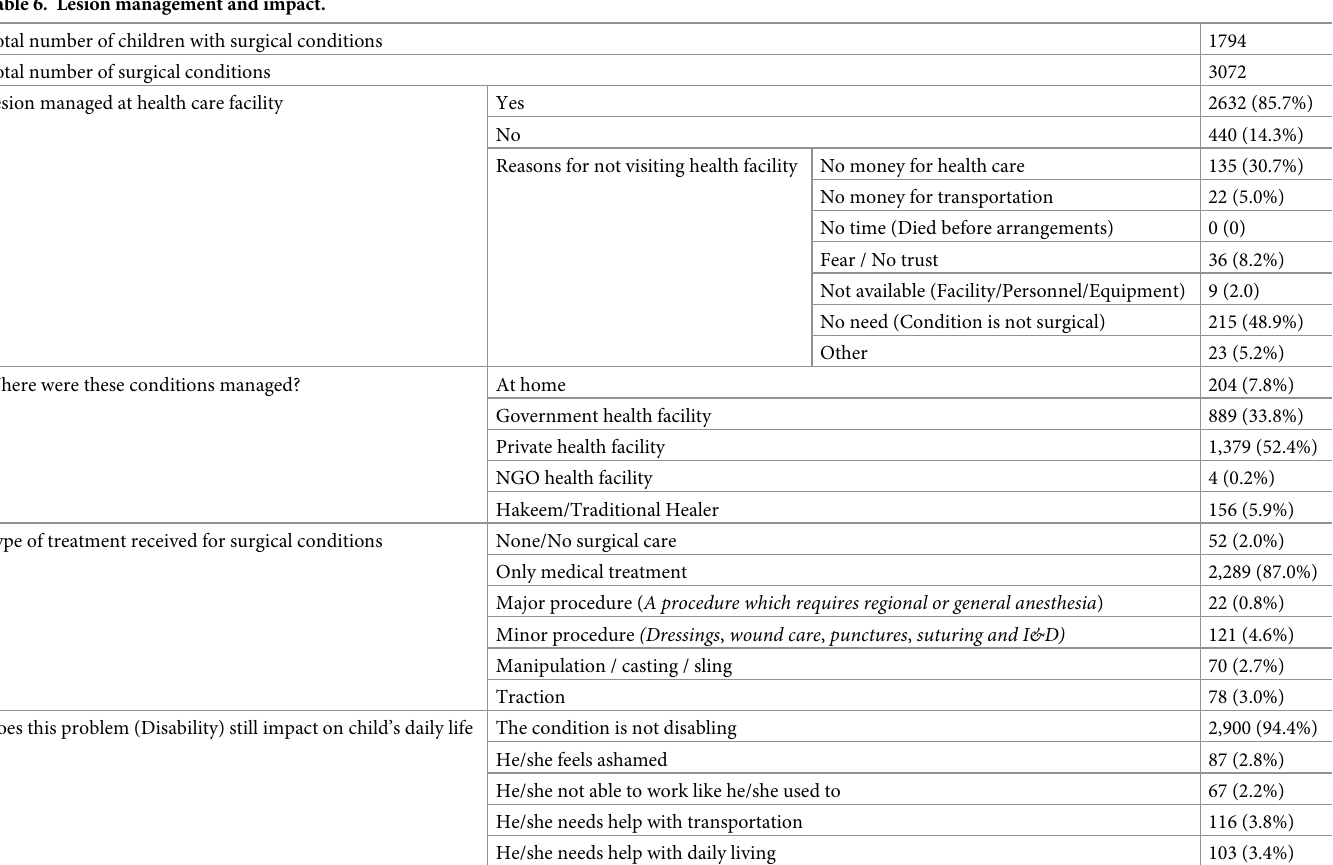
Table 6. Lesion management and